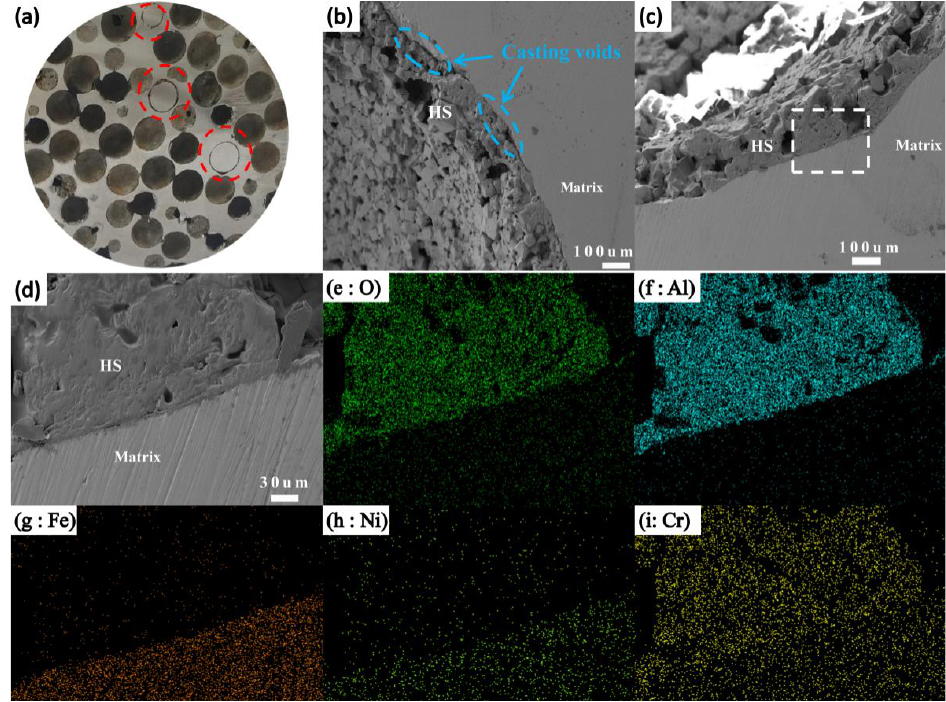
Figure 3. Macro photograph ( a ) and SEM images ( b , c ) of SSFs. Magnification of the interface structure ( d ) and the corresponding EDS map ( e – i ).